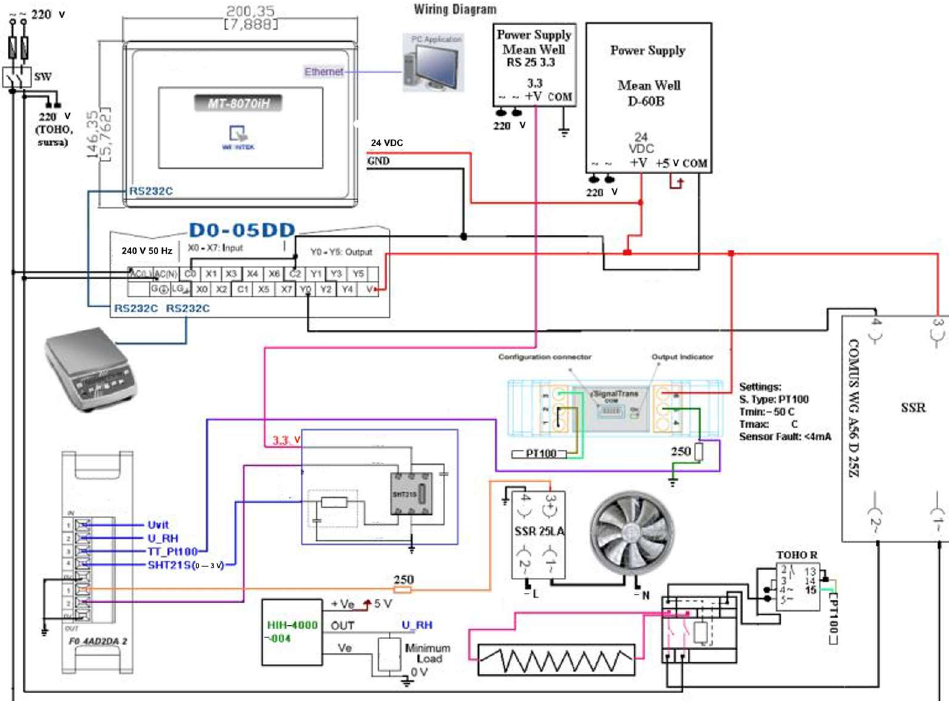
Figure 2. Drying plant electrical